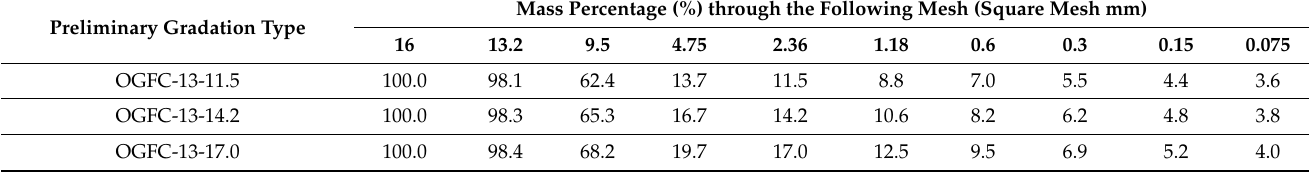
Table 7. Passage rates for each sieve hole of the initial test ore